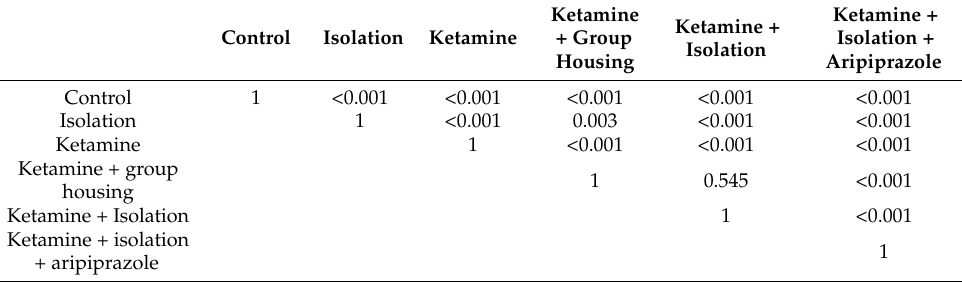
Table 6. All p -values for the level of MDA in the hippocampus.